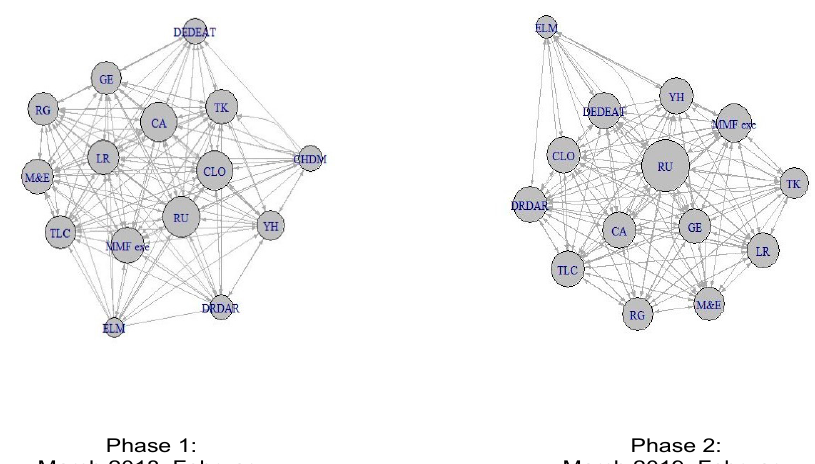
Figure 7. Overview of the common goals network. Arrows represent directed, weighted ties and circle size represents degree centrality. Rhodes University (RU), Department of Economic Development, Environmental Affairs, and Tourism (DEDEAT), Department of Rural Development and Agrarian Reform (DRDAR), Chris Hani District Municipality (CHDM), Emalahleni Local Municipality (ELM), Traditional Leaders Council (TLC), Masibambisane multi-actor forum executive (MMF exe), GEF5 Community liaison officers (CLO), Conservation Agriculture Hub (CA), Land Rehabilitation Hub (LR), Rangeland Management Hub (RG), Training and Knowledge Hub (TK), M&E Hub (M&E), Gender Equity Hub (GE), and Youth Hub (YH).